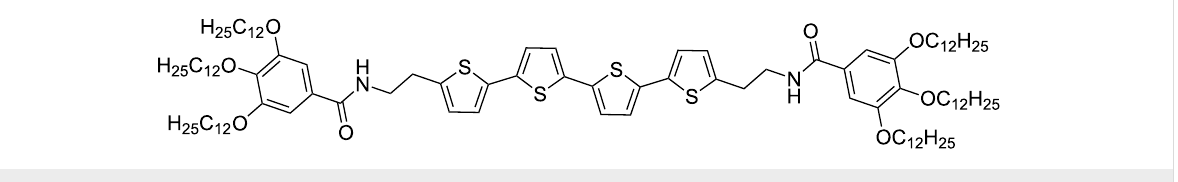
Scheme 1: Structure of the quarterthiophene derivative T1